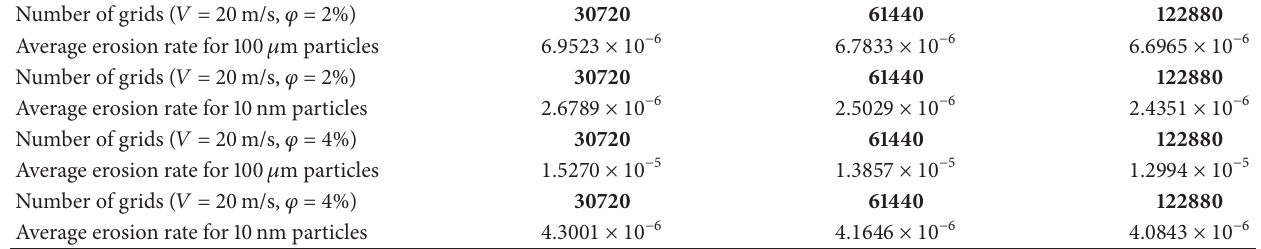
Table 3: Grid independence tests.